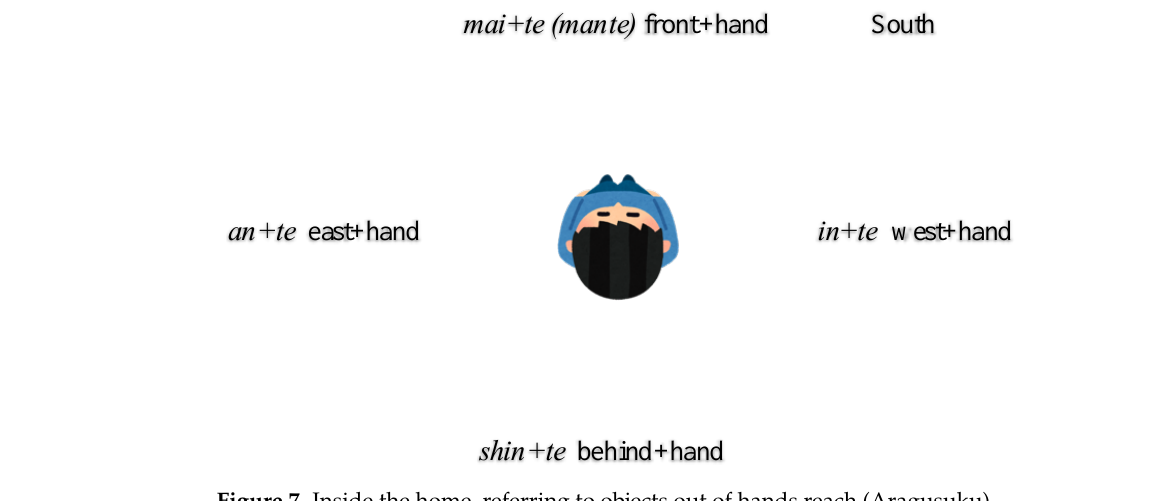
Figure 7. Inside the home, referring to objects out of hands reach (Aragusuku).